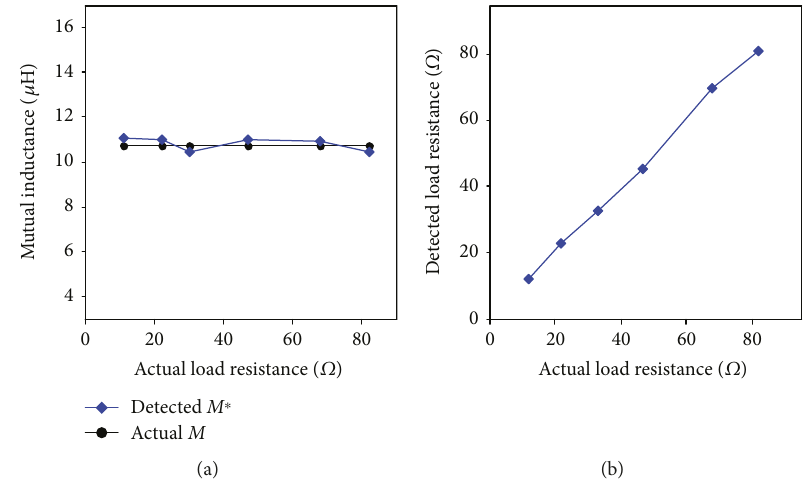
Figure 5: Detected results of (a) mutual inductance and (b) load resistance when actual load resistance varies.